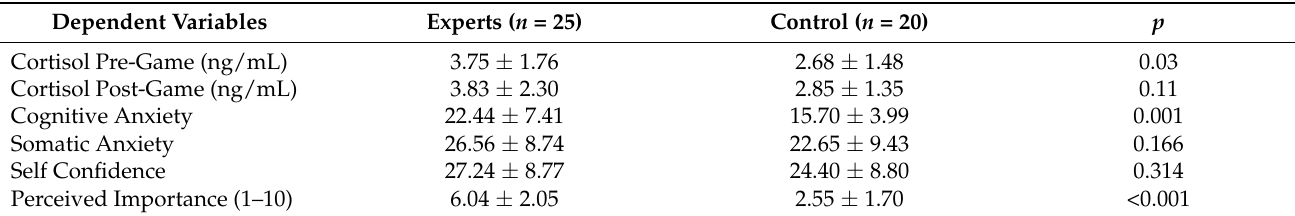
Figure 1. Mean ± SD for salivary cortisol levels between control and experts players. Pre C = pre-competitive salivary cortisol levels; Post C = post-competitive salivary cortisol levels. * p < 0.05. Pre-game cortisol levels were positively correlated with self-confidence (r = 0.470, p = 0.001) and with PMI (r = 0.411, p = 0.005), and negatively with somatic anxiety. At the end of the games, only self-confidence was correlated with post-game cortisol (Table 1). Table 1. Mean ± SD for salivary cortisol, anxiety, and perceived match importance differences between experts and control group ( n = 45).